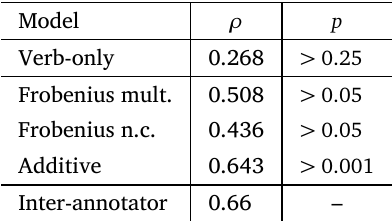
Results in the sentence entailment